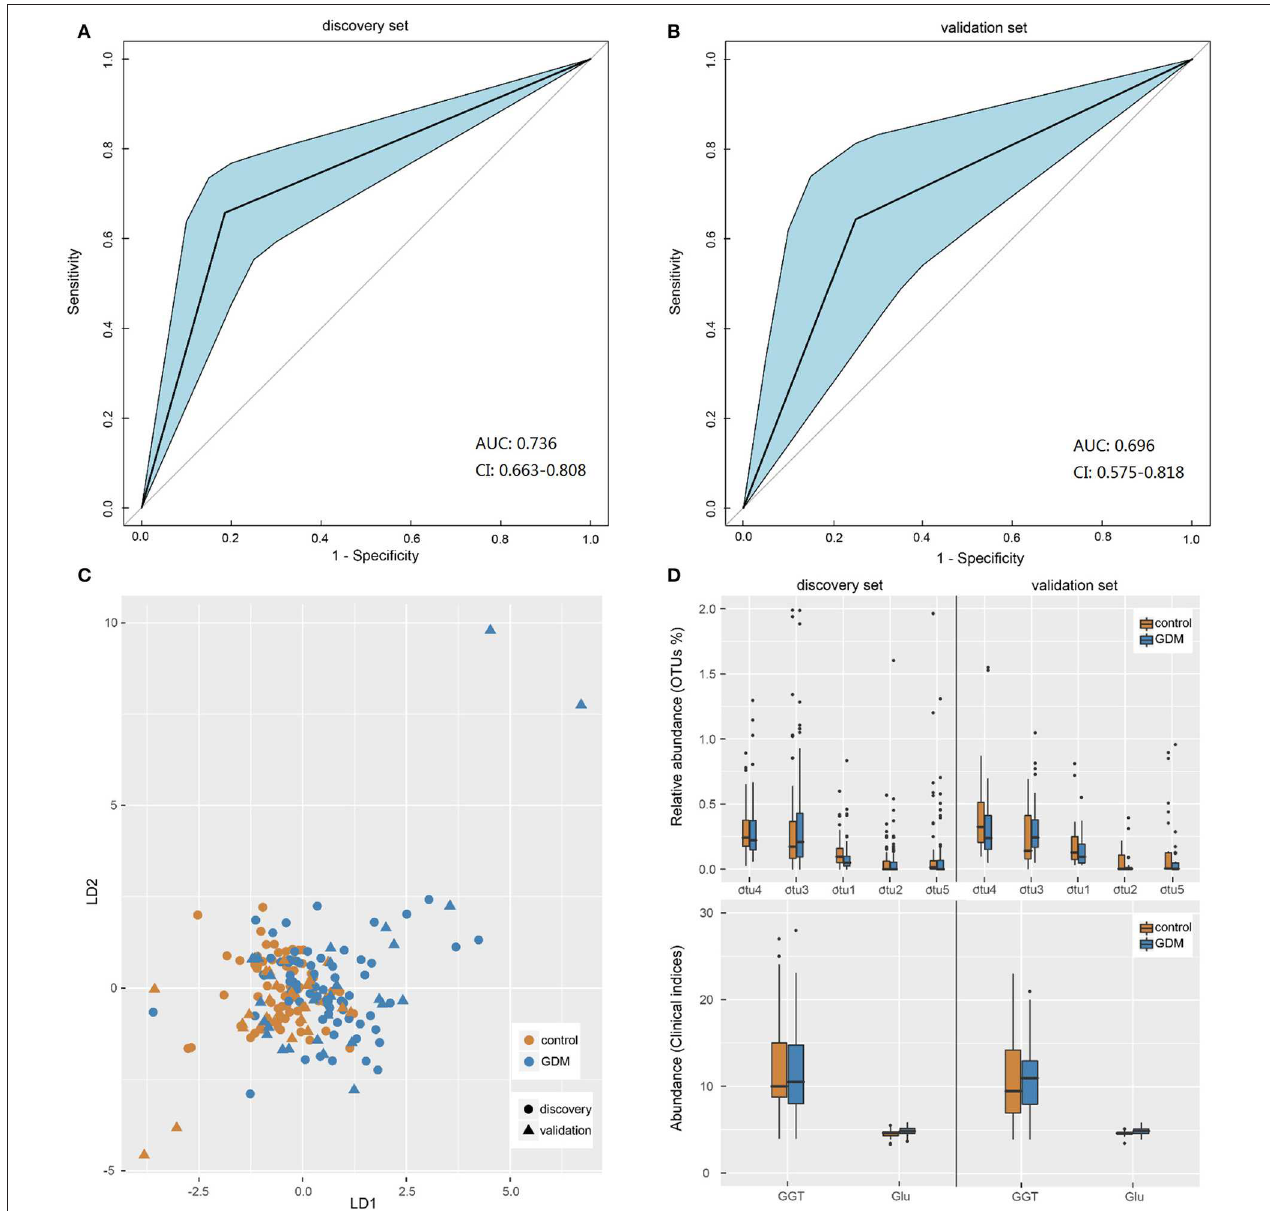
FIGURE 4 | Gut microbiota-based pattern recognition analysis for the diagnosis of GDM. (A,B) Receiver operating characteristic (ROC) curves for samples in discovery and validation sets. AUC, the areas under ROC curves; CI, confidence interval. (C) Scatter plot of all samples in discovery and validation sets based on first two axes obtained from Linear discriminant analysis. (D) The boxplot of the seven features utilized in the model for samples in discovery and validation sets. The otu1, 2, 3, 4, 5 were genera Uncultured-Ruminococcaceae , Alloprevotella , Ruminococcus 2 , Parabacteroides , and Ruminococcaceae UCG-014 , respectively. GGT, glutamine transpeptidase; Glu, fasting blood glucose.